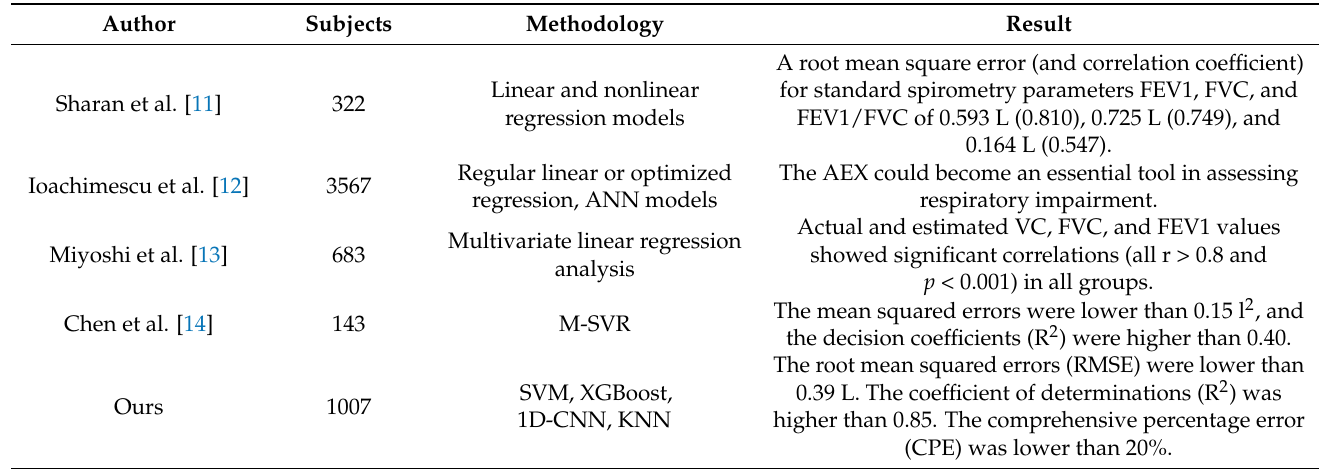
Table 8. Performance comparison with other